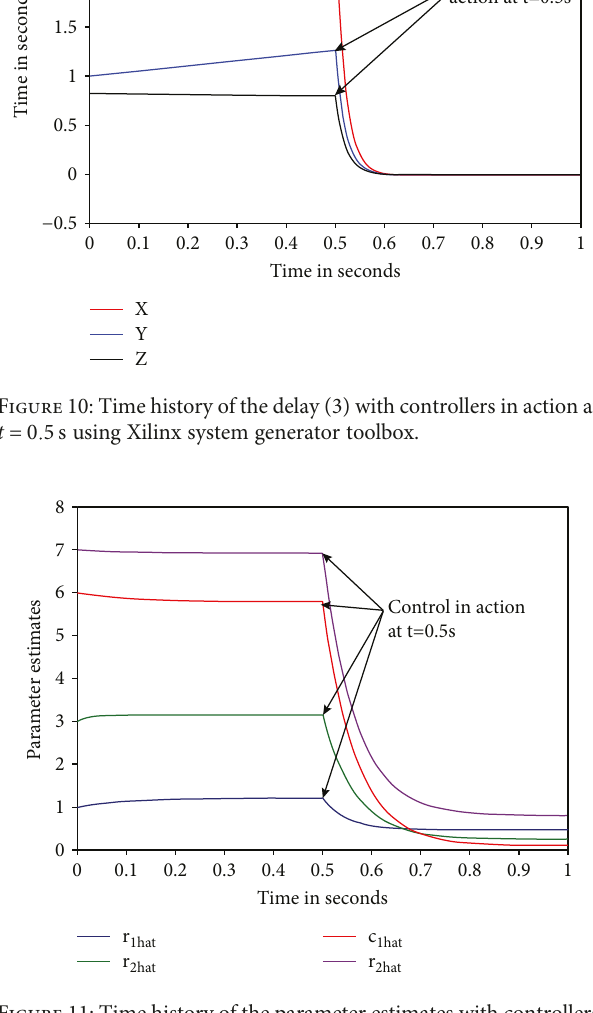
Figure 11: Time history of the parameter estimates with controllers in action at t = 0 5 s using Xilinx system generator toolbox.